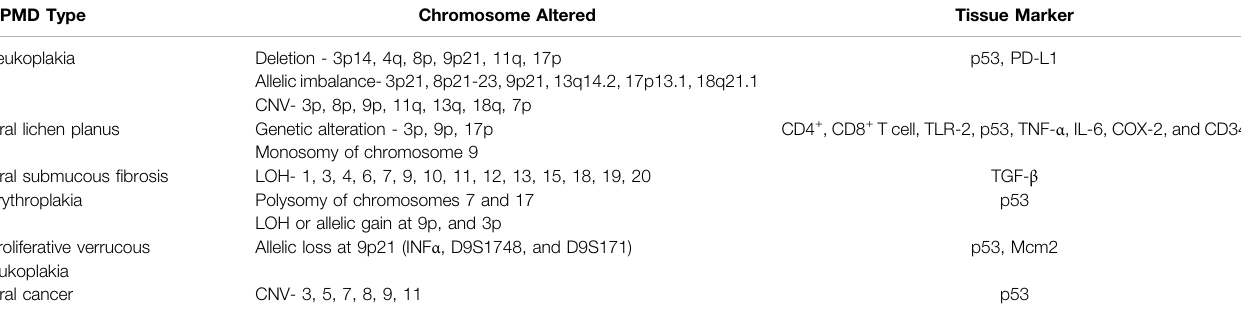
TABLE 3 | List of identi fi ed genetic alteration at chromosome level and tissue marker present in OPMDs. OPMD